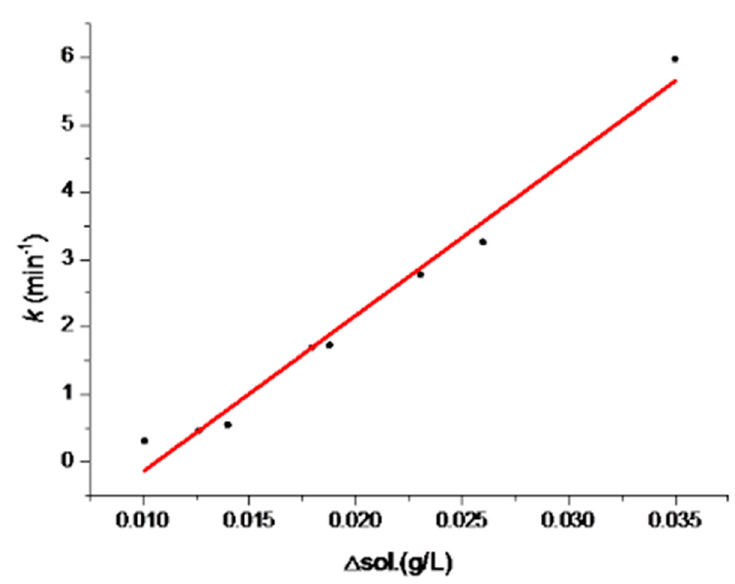
Figure 9. Correlation of SMPT rate constants ( k ) and the difference value between the solubilities of Form I and Form II ( ∆ S ) in mixed solvent system.